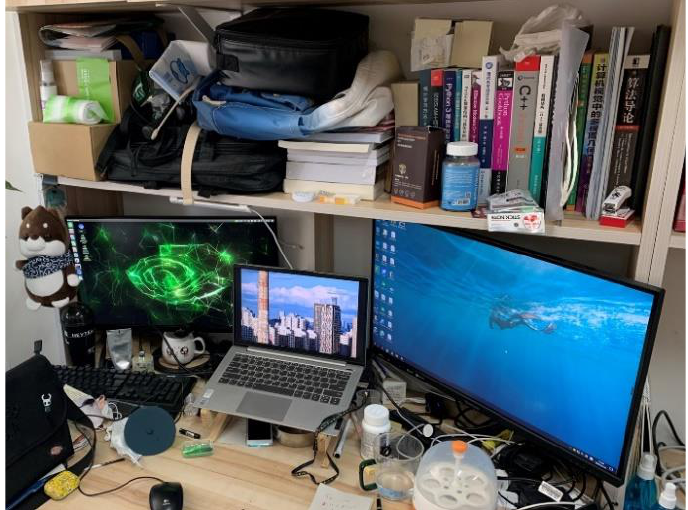
Figure 14. Image of another experimental scene.